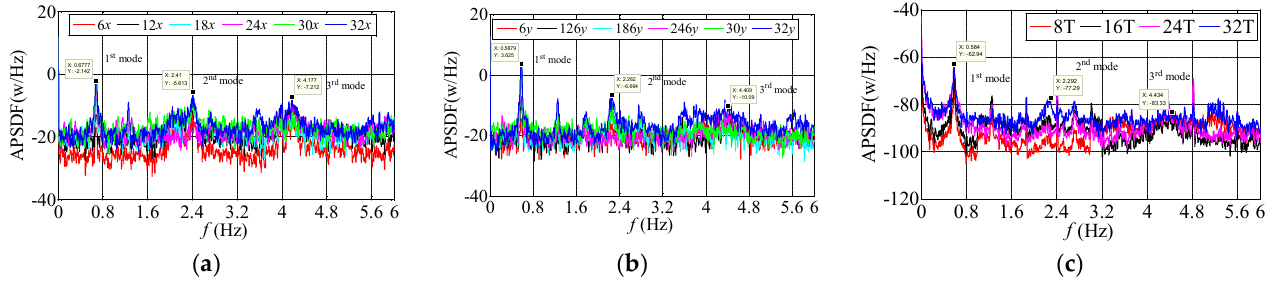
Figure 11. The measured APSDF when U 10min = 2.60 m/s. ( a ) APSDF along x -axis; ( b ) APSDF along y -axis; ( c ) APSDF along torsional direction.